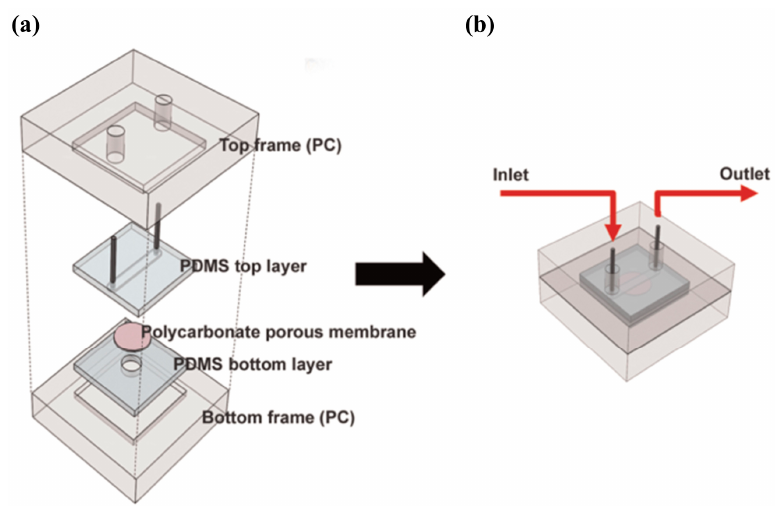
Figure 12. Schematic of the microfluidic system. ( a ) Device assembly. ( b ) Assembled microfluidic device and injection process. Reproduced with permission from [50] Copyright 2015, Elsevier.